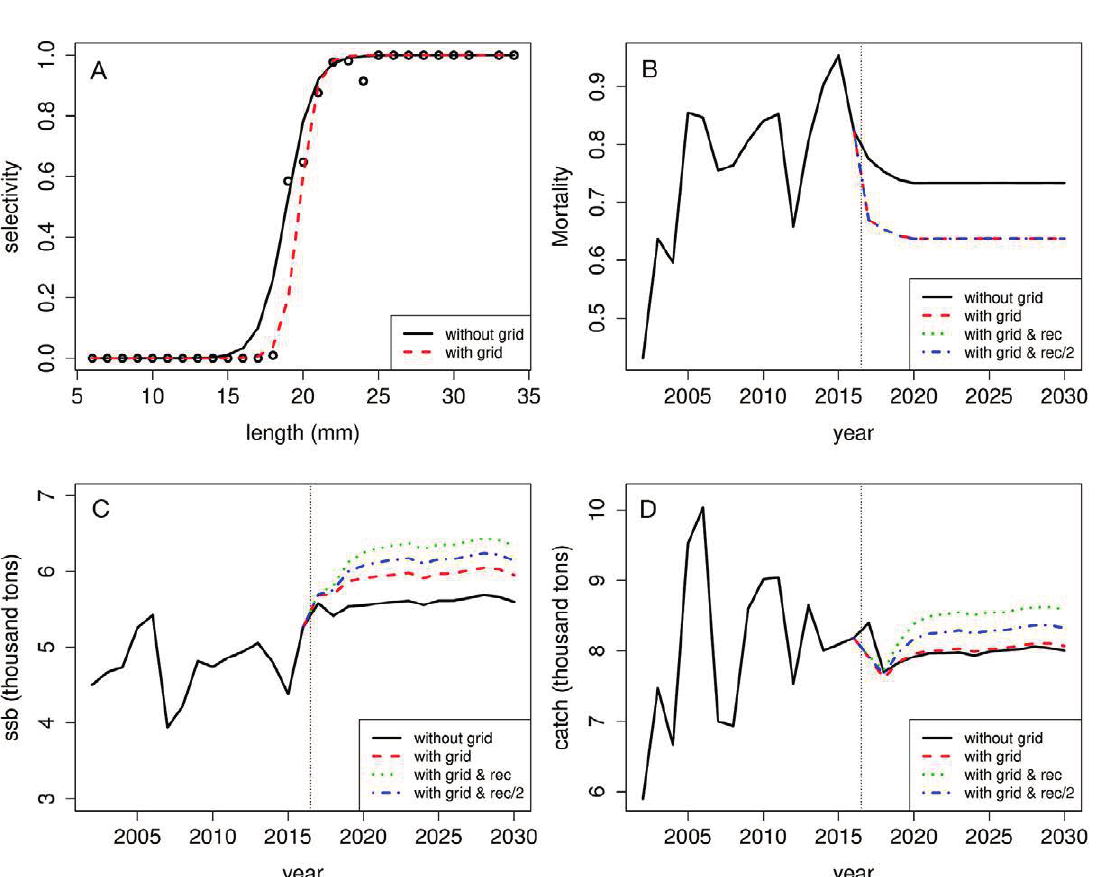
Fig. 4. – Gadget simulations plots of DPS comparing the trawl nets without grid (Scenario I: black solid line) and with grid (Scenario II, red dashed line; Scenario III, green dashed line; Scenario IV, blue dashed line). A, selectivity curves of DPS, circles represent the new proportions of specimens, by length class, retained by the net with grid, forecast up to 2030; B, fishing mortality (F); C, spawning stock biomass (SSB); D, catch.